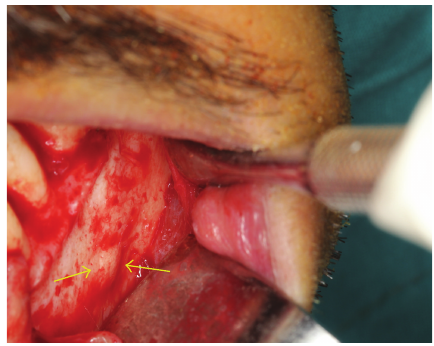
Figure 6: Clinical appearance of the protuberance at the mental foramen area on the left